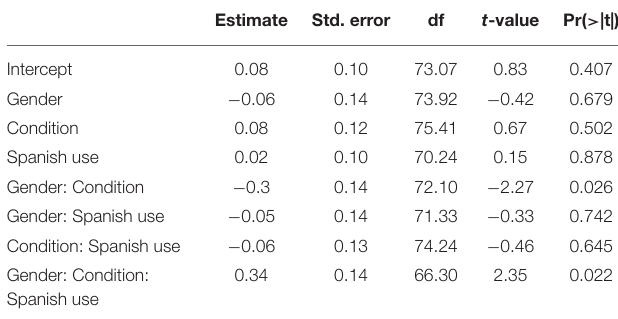
TABLE 5 | Results of LME on DFPT by target gender, condition, and Spanish use in the post-pause region. Estimate Std.